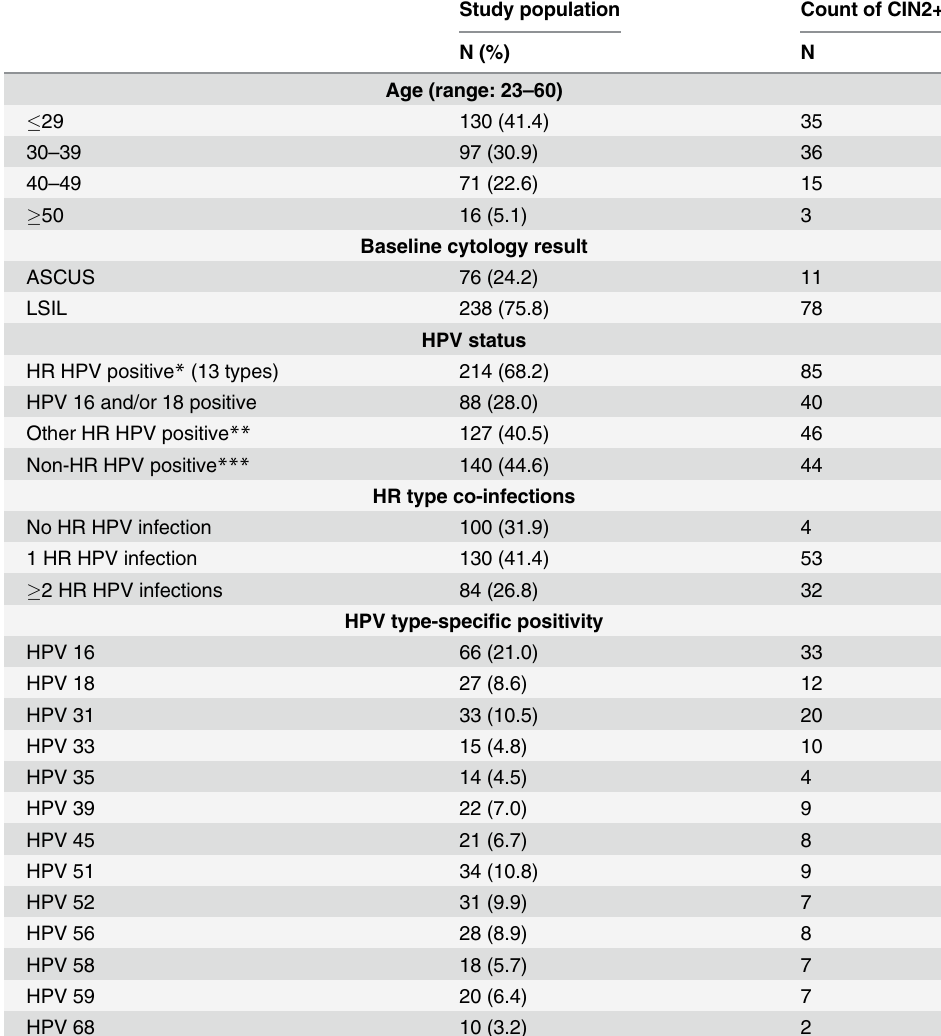
Table 1. Distribution of background characteristics among 314 women with ASCUS/LSIL index cytologies. Study population Count of